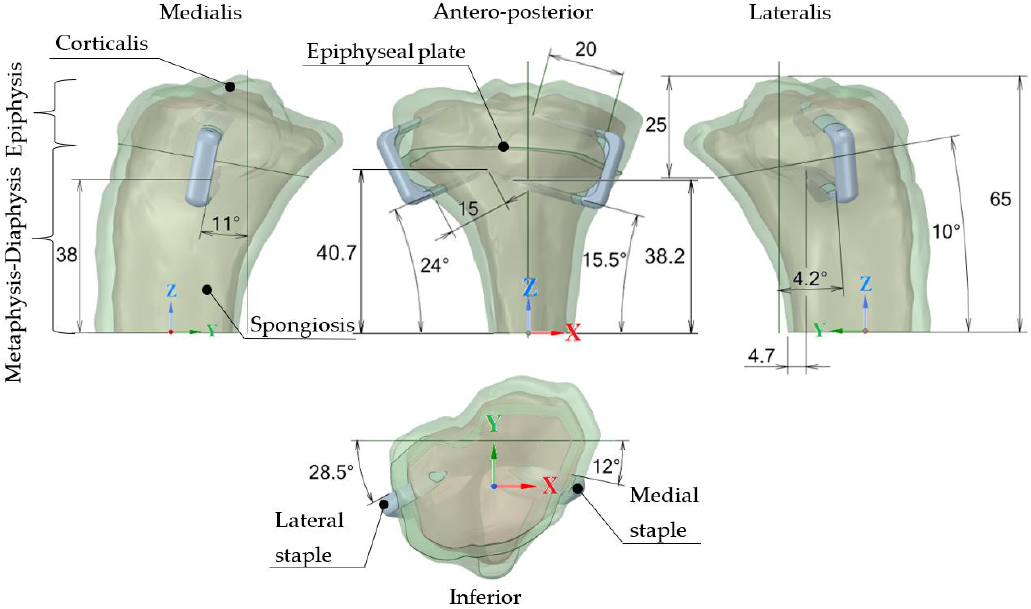
Figure 6. 3D CAD model of the bone and staples with main dimensions (mm).